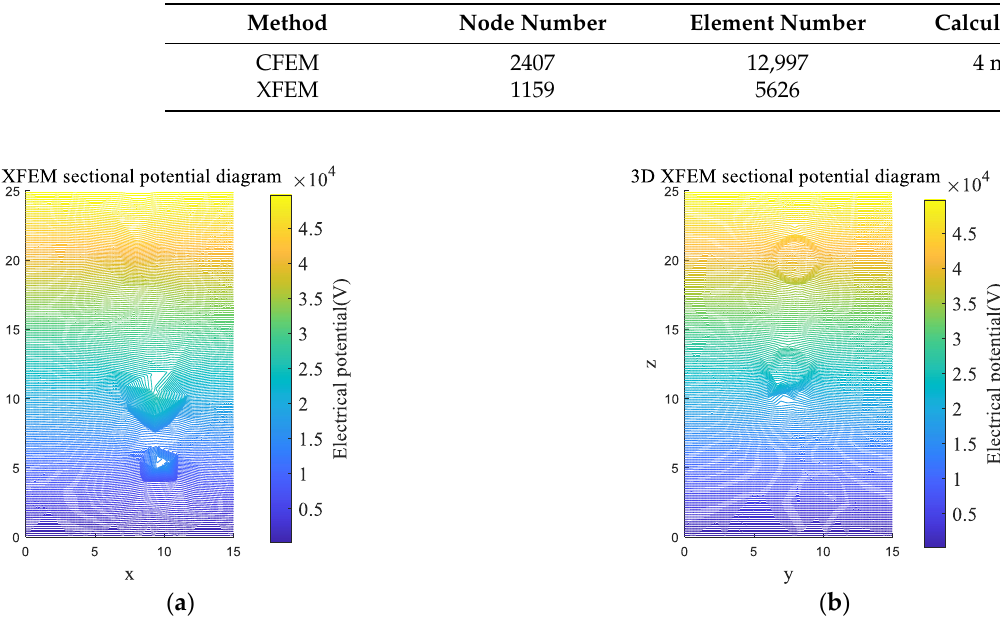
Table 4. Contrast of number of nodes and elements in 5 bubbles.